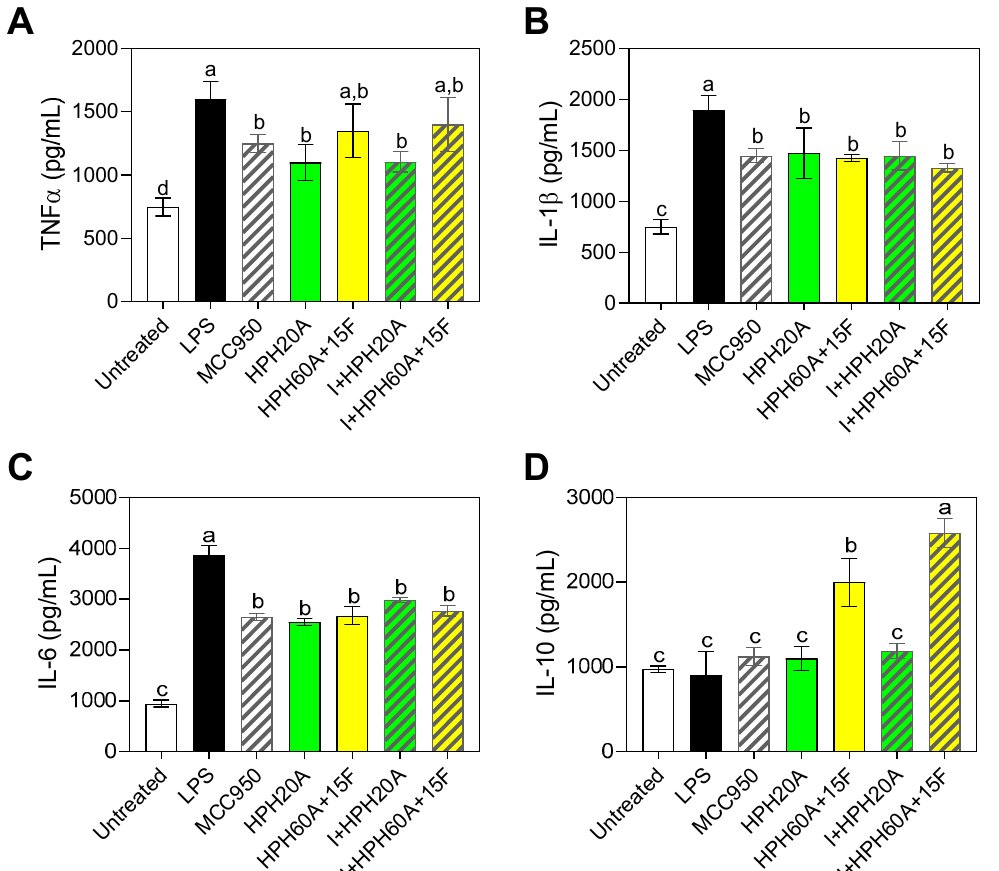
Figure 4. Secretion of TNF- α ( A ), IL-1 β ( B ), IL-6 ( C ), and IL-10 ( D ) in BV-2 cells after 24 h incubation with or without stimulation with LPS (1 µ g/mL), as well as following treatment with MCC950 (I), a specific inhibitor of the inflammasome, and/or with HPHs (100 µ g/mL). Values are presented as the means ± SDs ( n = 3); Different letters denote significant differences among the samples. ( p < 0.05)